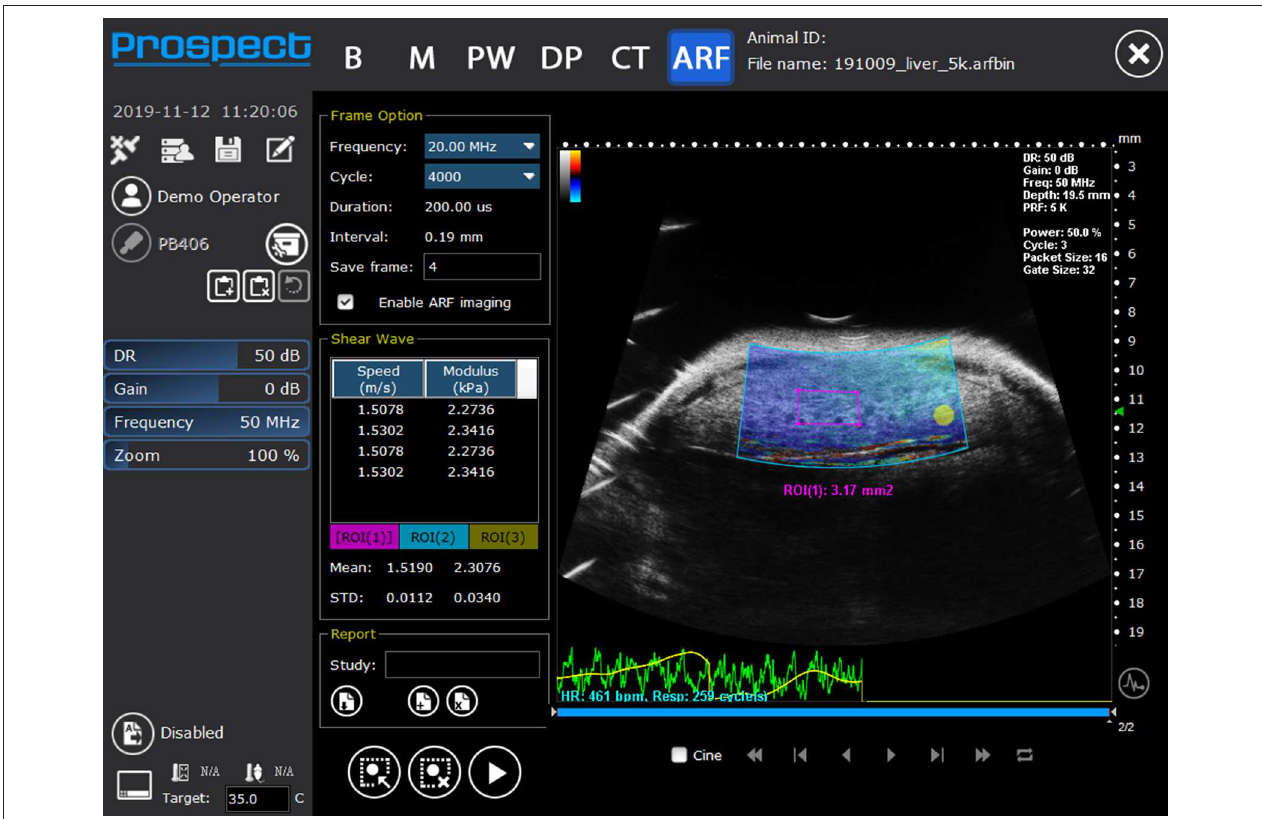
FIGURE 8 | Shear wave elastography image of liver showing mean shear wave velocities and Young’s modulus from a mouse liver (Reproduced with permission from S-Sharp